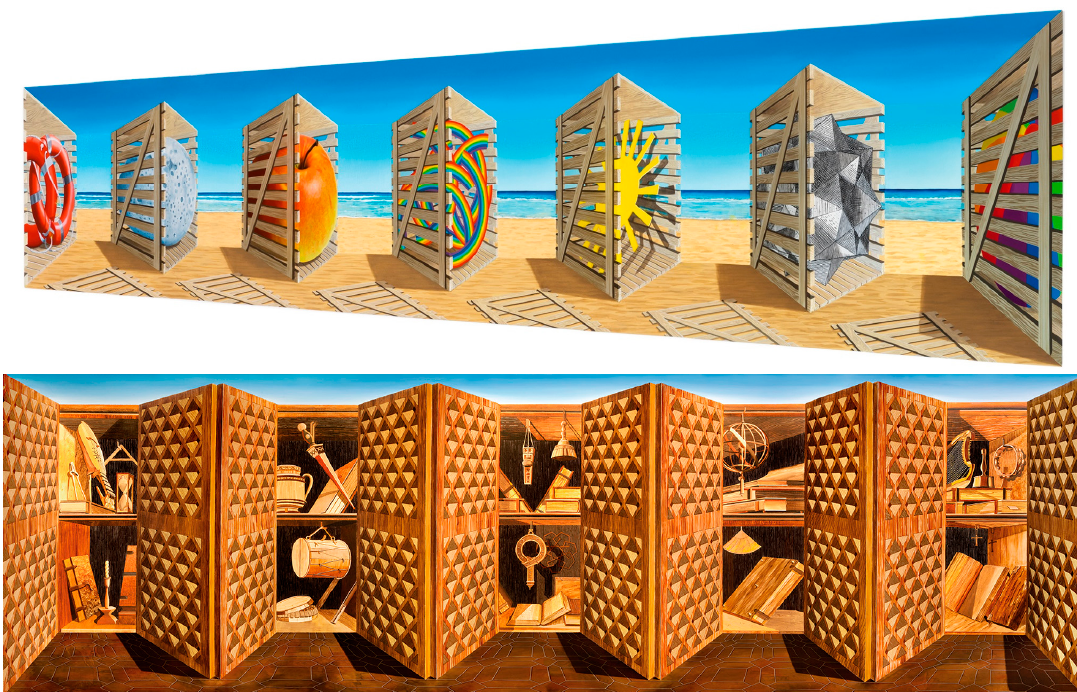
Figure 4. Top panel: “Crate Expectations” (2018). Notice that the central edge of each crate appears to be closer to the viewer than any other part of that crate; in reality, this central edge is the farthest part of the crate. Bottom panel: “A Study of the Studiolo” (2013). The five opened closets appear to be further than the doors, whereas they are closer to the viewer than the doors.